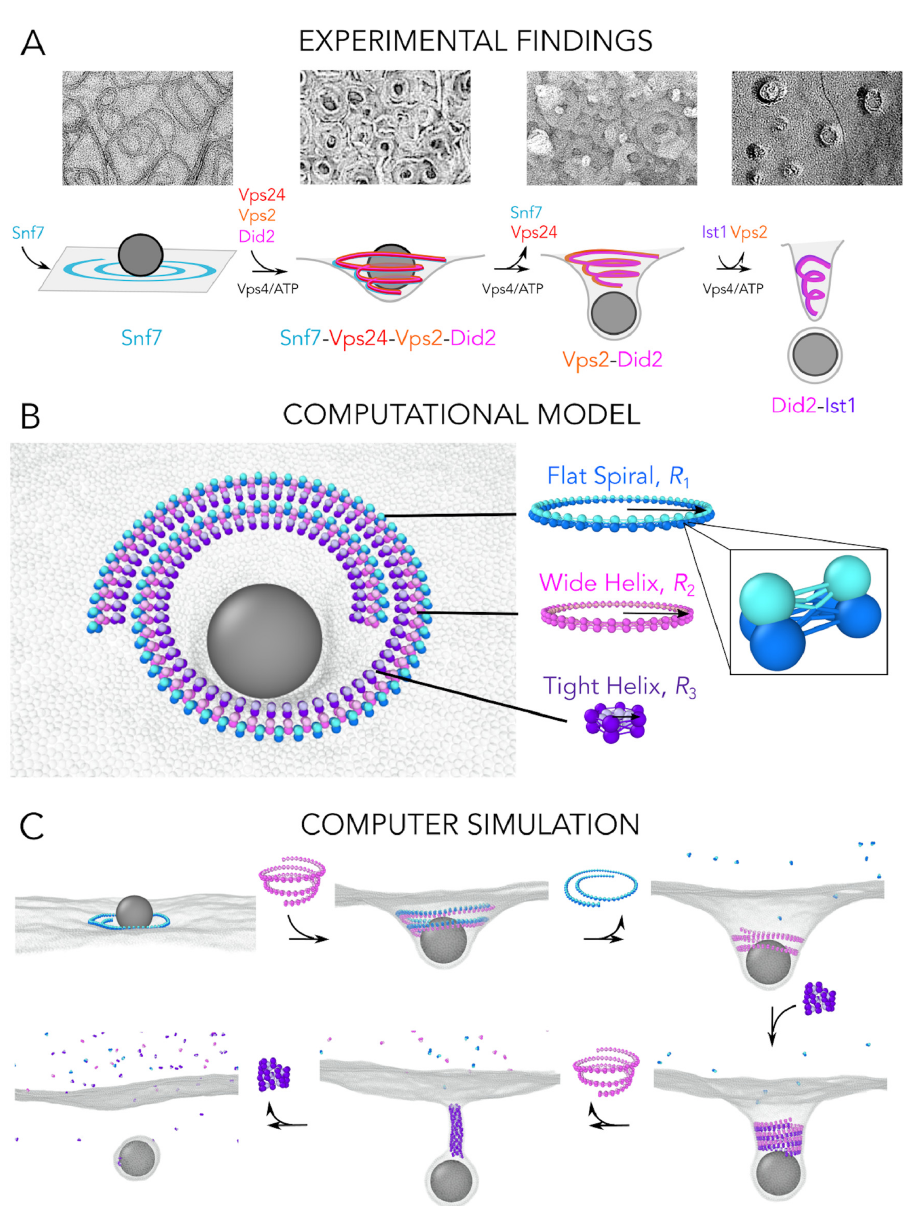
Fig 1. Experimental findings and computational model. A: Negative stain EM images of Snf7, Snf7-Vps24-Vps2-Did2, Vps2-Did2 and cryofreeze-fracture image of Did2-Ist1 on large giant unilamellar vesicles. Experimental protocols are detailed in S1 Appendix. The schematic cartoon representation of the ESCRT-III mediated cargo budding pathway is shown below, based on Ref. [17]. B: The model for the ESCRT-III system consists of three copolymerising filaments: a Flat Spiral (depicted in blue) of a preferential radius of curvature R 1 , a Wide Helix (depicted in pink) of a preferential radius R 2 , and a Tight Helix (depicted in purple) of a preferential radius R 3 , where R 1 > R 2 > R 3 . Each filament consists of three-beaded subunits connected by 9 bonds, which control the filament target geometry (inset). The membrane-binding face of each filament is highlighted in darker colors, and the membrane is shown in grey. A generic cargo particle corralled by the ESCRT-III filaments is shown in dark grey. C: Snapshots highlighting the stepwise activation and disassembly protocol of the three filaments, leading to fission of a cargo- loaded